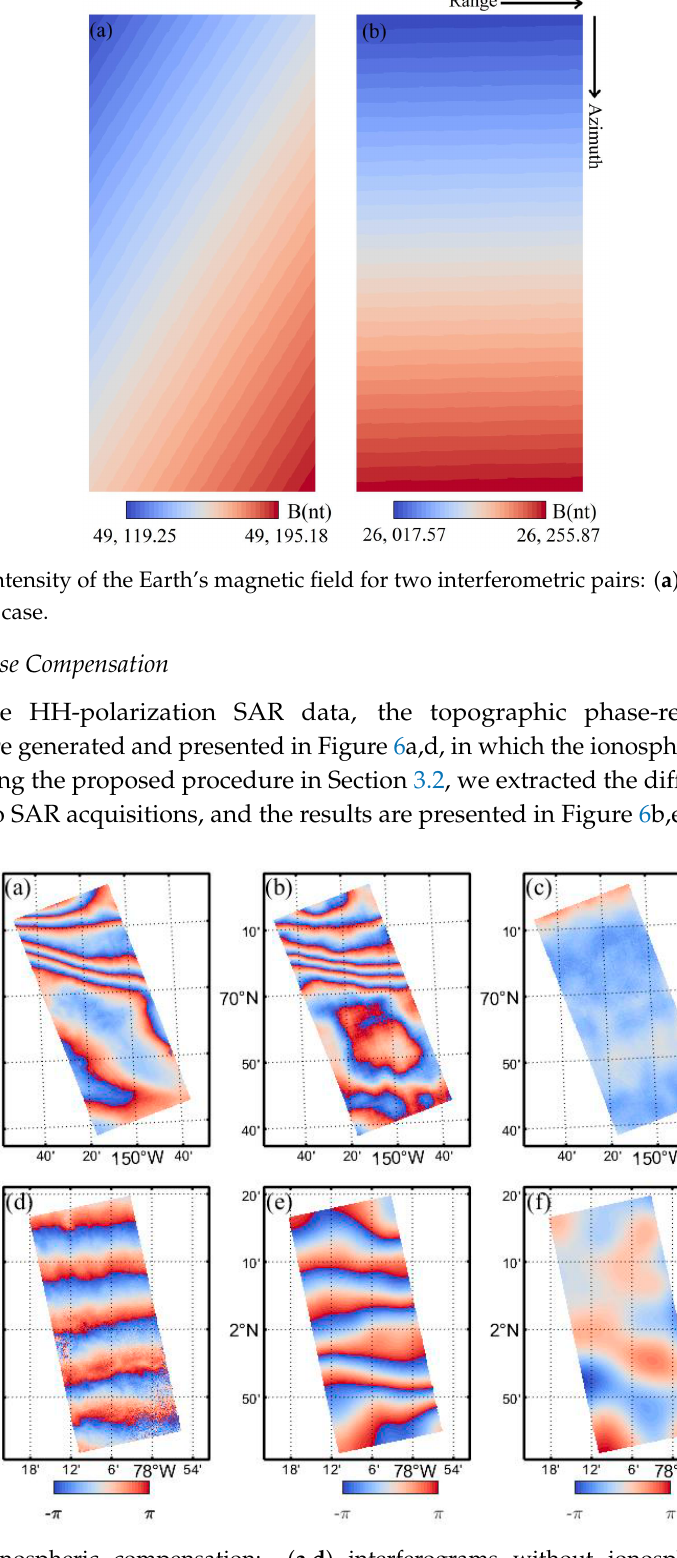
Figure 6. Ionospheric compensation: ( a , d ) interferograms without ionospheric correction, ( b , e ) estimated ionosphere phase screen (wrapped) derived from the algorithm described in our study, ( c , f ) interferograms with ionospheric compensation.